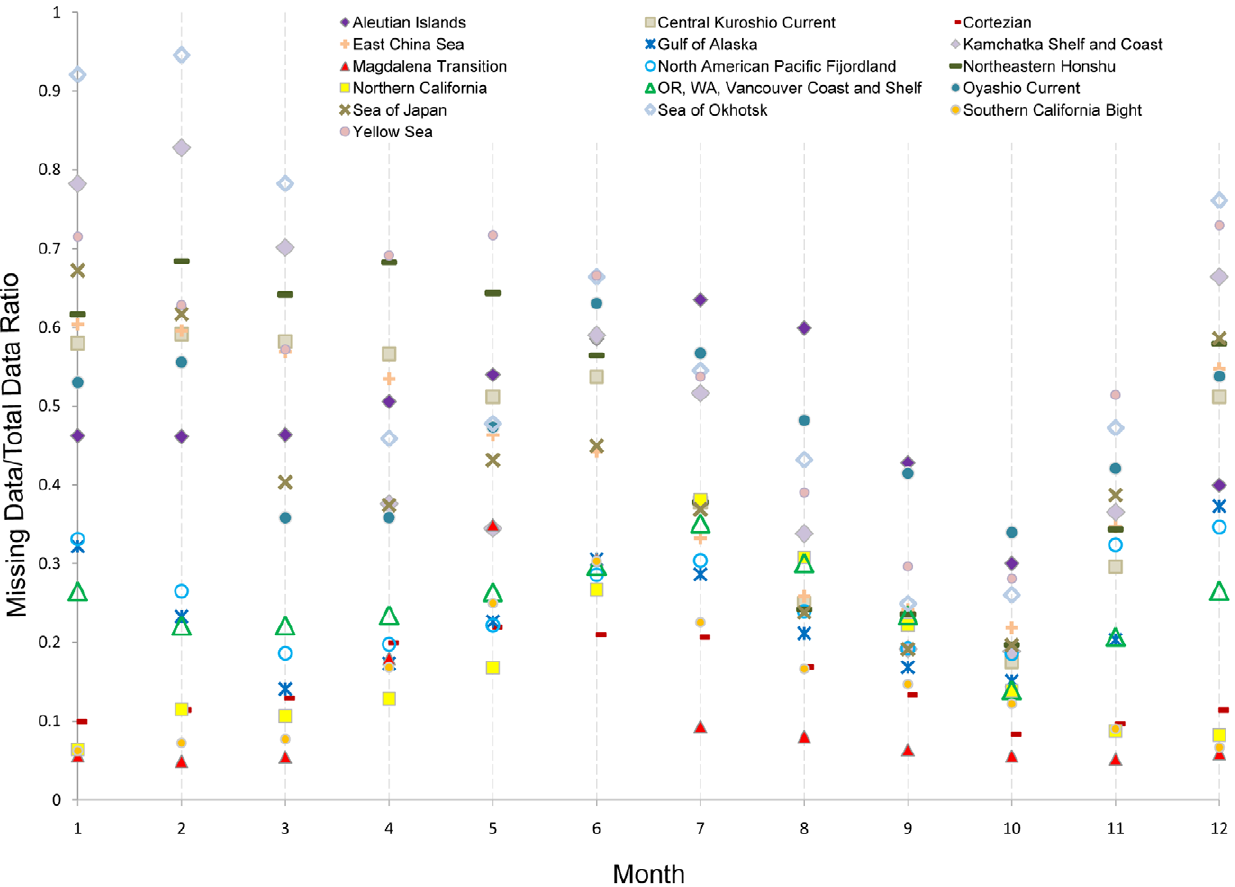
Figure 4. Fraction of missing data points for each month aggregated over the 29-year SST time series. Each individual month (e.g. all 29 Januarys) has over half-a-million possible SST point values. Although subarctic ecoregions tend to have a greater percent of missing data compared to lower-latitude ecoregions, at least 40,000 SST values meeting the quality criteria were present in the Temperate North Pacific study area for each of the months evaluated.